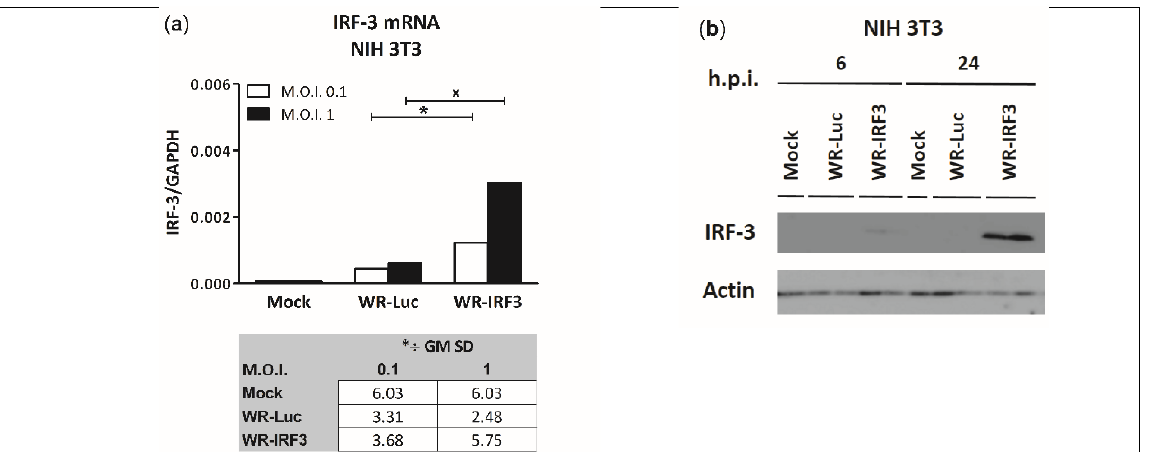
Figure 1. Expression of mouse IRF-3 by WR-IRF3 in NIH 3T3 fibroblast cell line. The cells were mock-infected or infected with WR-Luc or WR-IRF3 at M.O.I. of 0.1 and 1. At individual time points, the cells were collected and used for further analysis. ( a ) 1-step RT-qPCR analysis at 24 h.p.i. IRF-3 mRNA was normalized to GAPDH mRNA and expressed as GM * ÷ GM SD; n = 4. Statistically significant differences at x p < 0.1, * p < 0.05 (one-tailed unpaired Student’s t -test). ( b ) Western blot analysis. M.O.I. of 1. The cell lysates were resolved by 10 % SDS-PAGE. IRF-3 and control β -actin were detected by western blot analysis and chemiluminescence. Mock, mock-infected cells; WR-Luc, cells infected with VACV expressing luciferase; WR-IRF3, cells infected with VACV expressing Mu IRF-3.